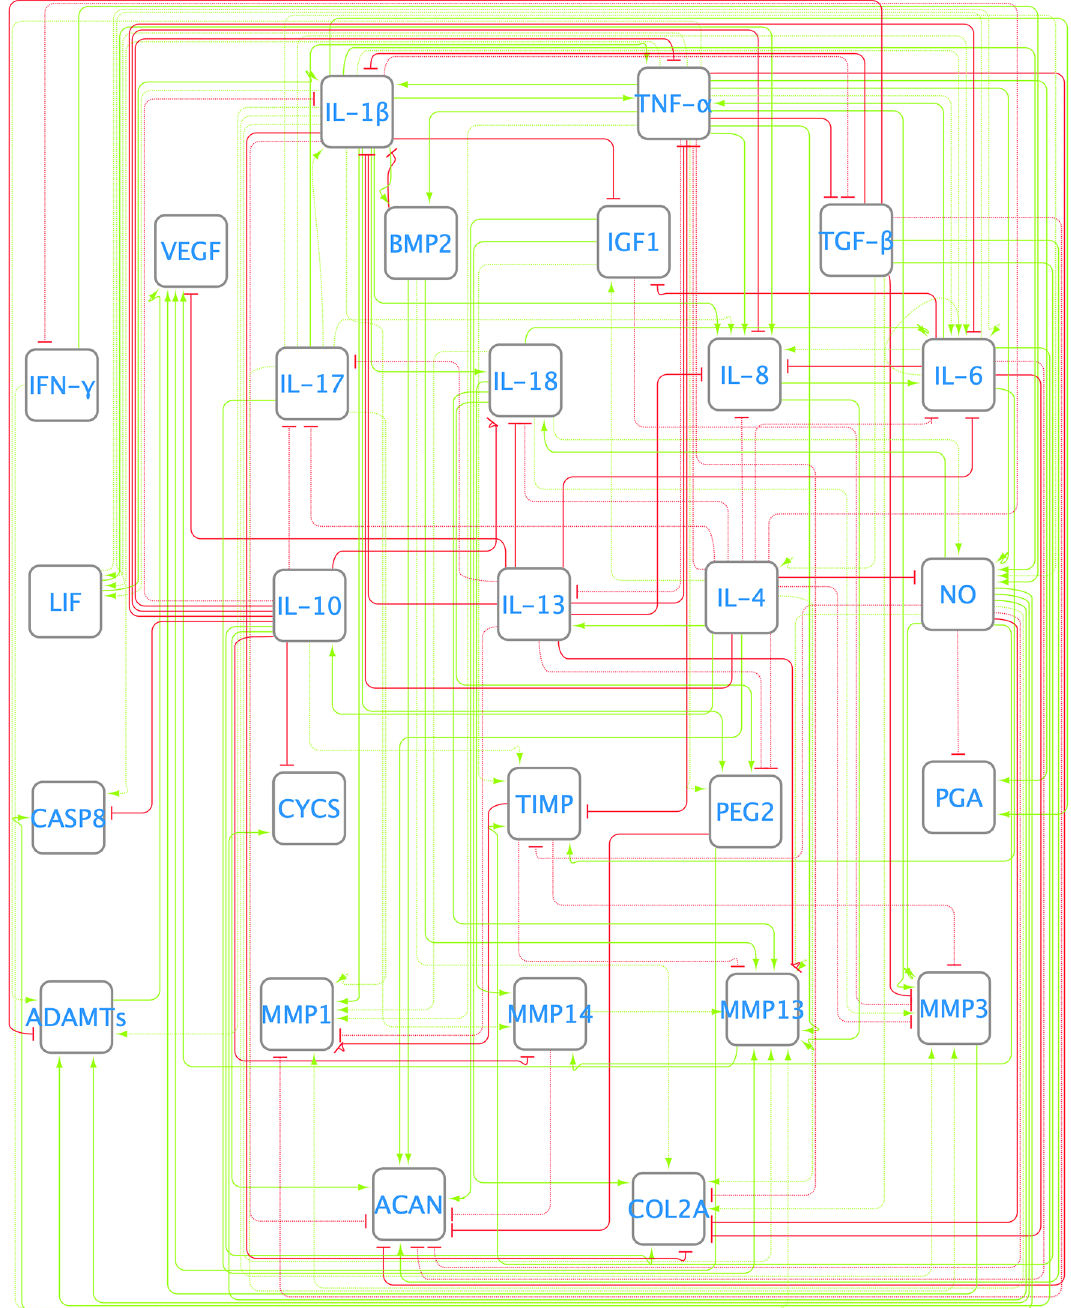
Figure 5. Optimized network (OPT). It was achieved by an optimization process based on a genetic algorithm. The dotted lines are the ones that the GA has eliminated. The summarized interactions can be found in Additional Material 1 A1 Table